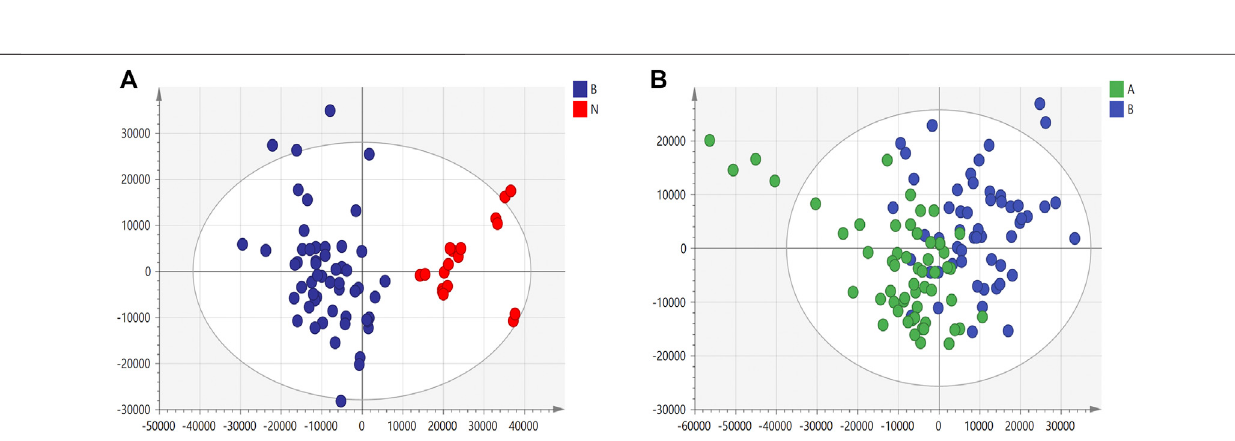
Frontiers in Pharmacology |